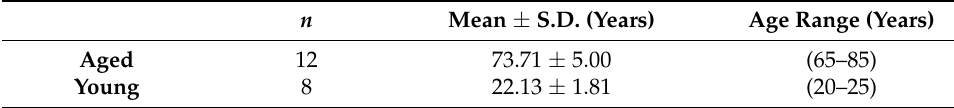
Table 1. Aged and Young PRP pools feature.